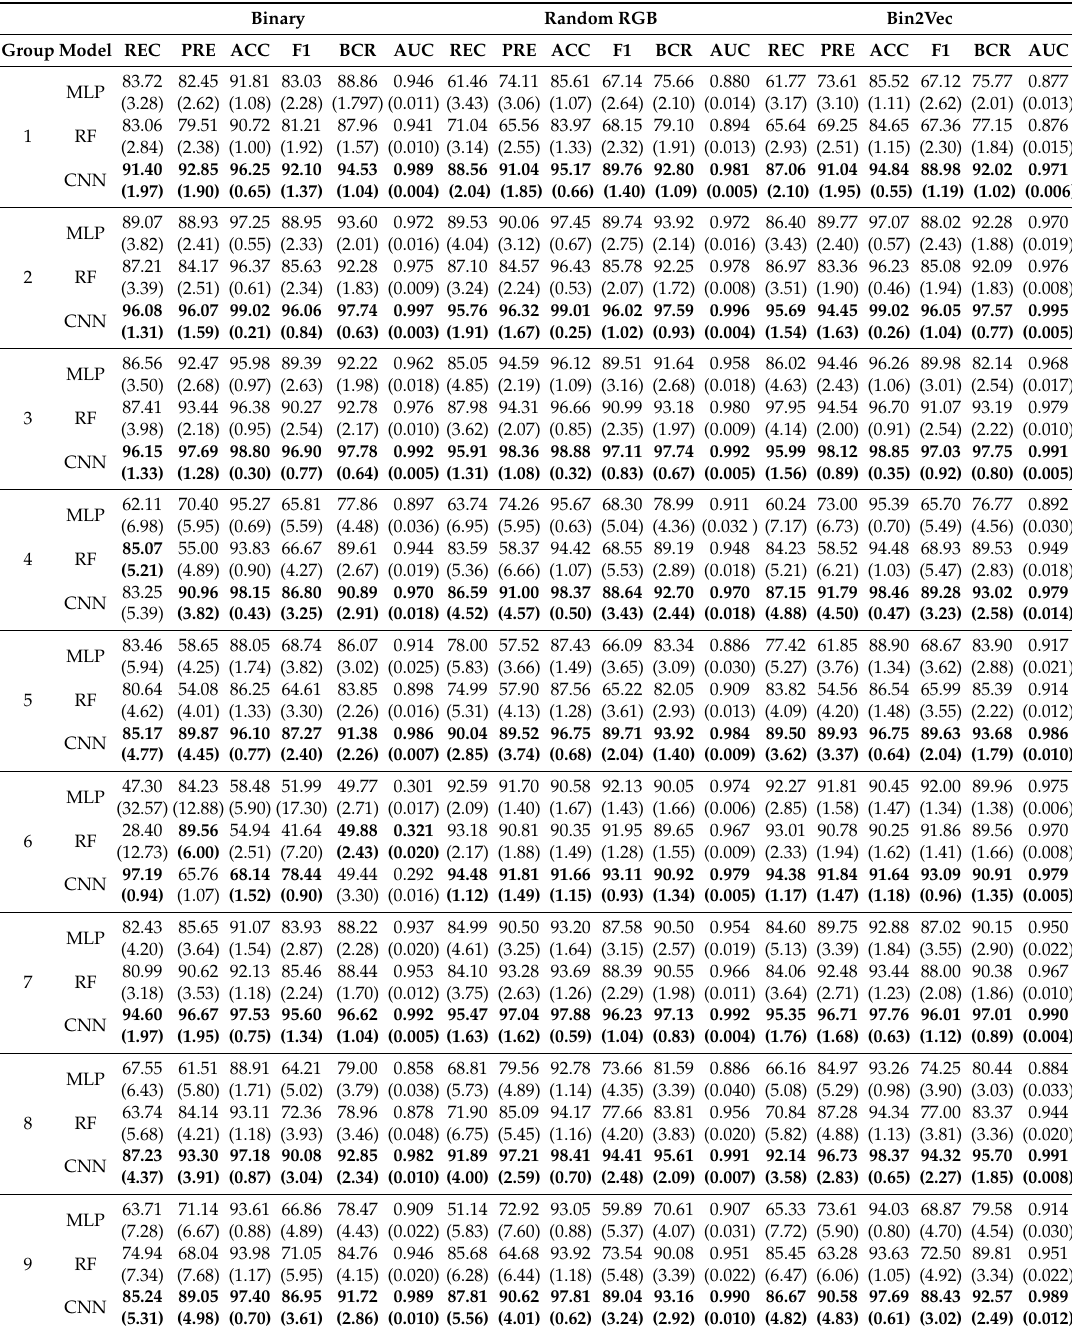
Table 4. Classification of Good and Bad WBM results from group 1 to group 9 (Values without/with parenthesis are the average/standard deviation of 30 trials, respectively; in bold face are the best performance for each group and